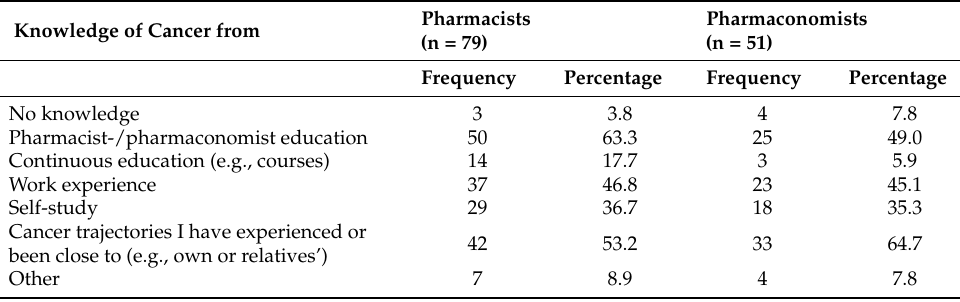
Table 3. Indications of where respondent’s knowledge about cancer came from.